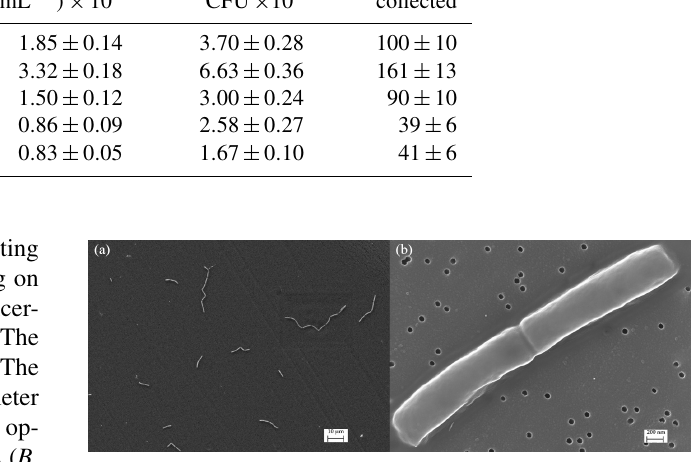
Table 2. Bacteria concentration ( B. subtilis ) in the aerosolized solution and average number of colonies counted on one Petri dish. OD 600 Suspension concentration Bacteria injected Average CFU (CFUmL − 1 ) × 10 7 CFU × 10 7 collected